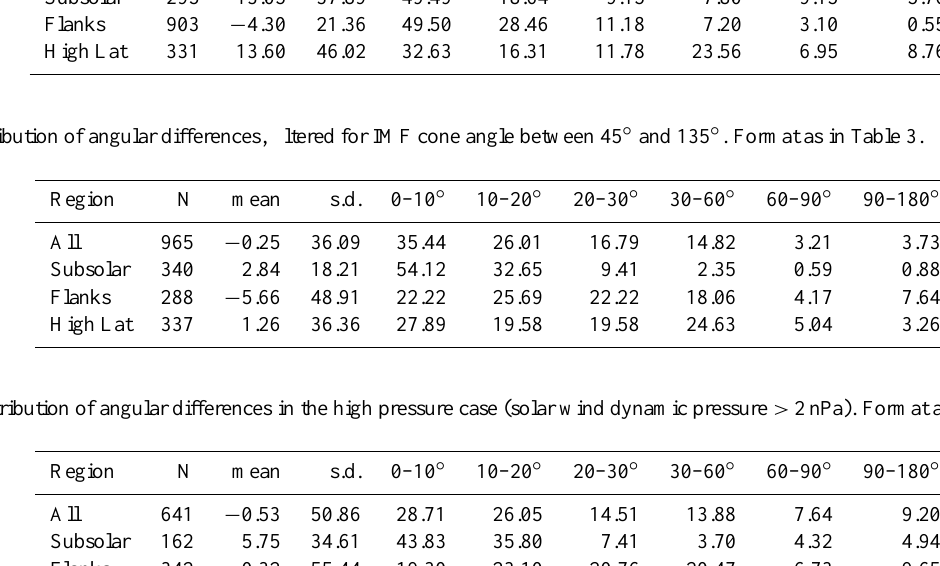
Table 8. Distribution of angular differences in the B y negative case (IMF clock angle between − 135 ◦ and − 45 ◦ ). Format as in Table 3. Region N mean s.d. 0–10 ◦ All 1529 Subsolar 295 Flanks 903 − 4.30 High Lat 331